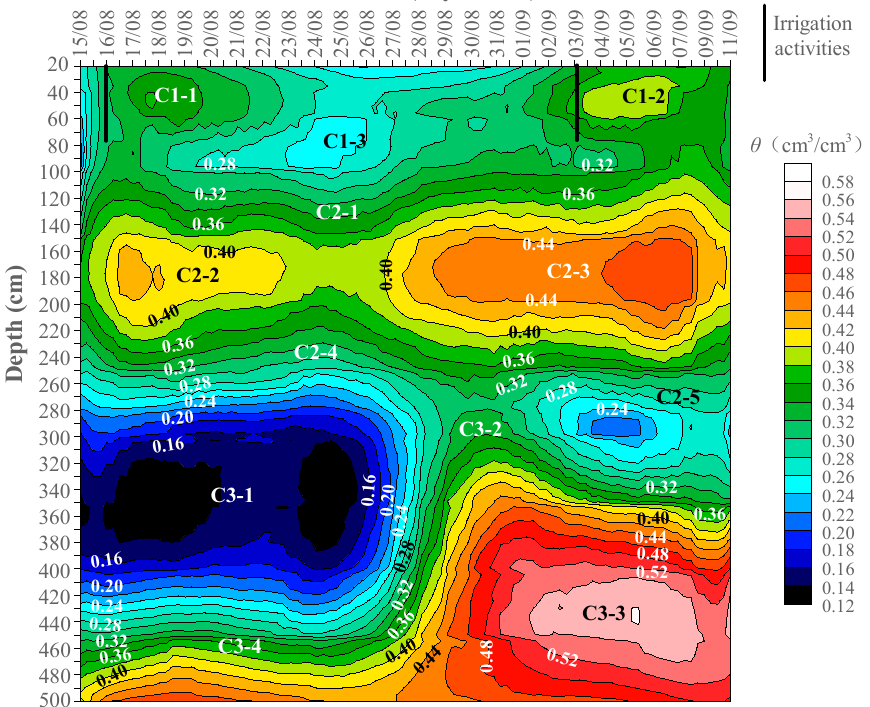
Figure 9. The soil moisture isogram of time and depth at point 17 with the crop of millet.